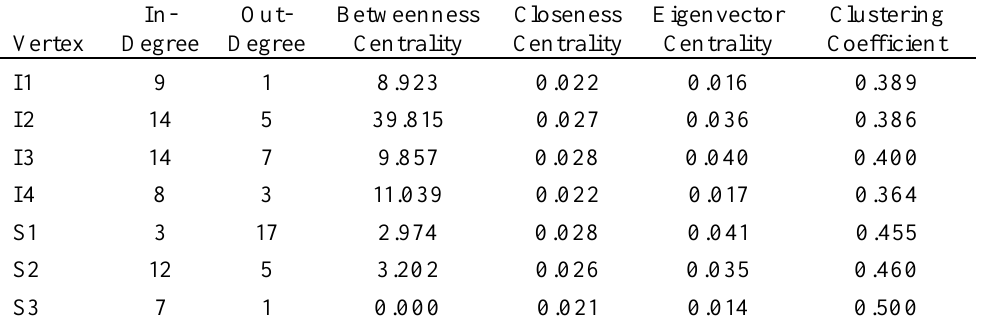
Betweeness and Closeness Centrality in the Initial Four Week Period